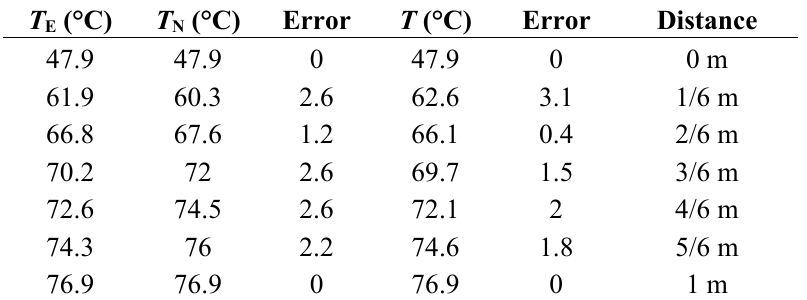
Table 3. Temperature distribution of the cold flow in two sides of the central channel of the plate heat